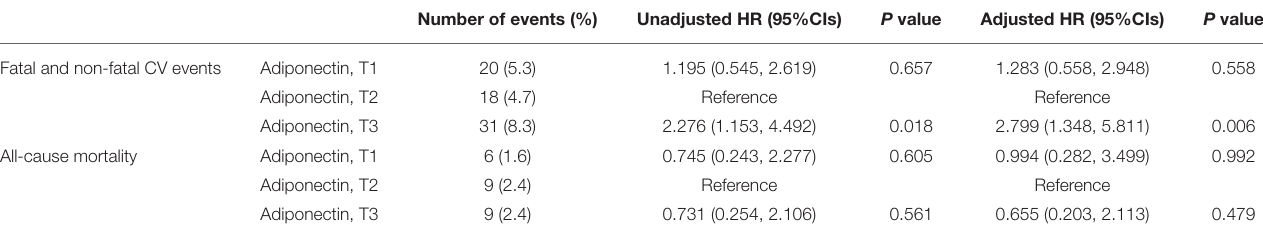
TABLE 2 | Cox regression analysis of serum adiponectin levels for clinical outcomes.